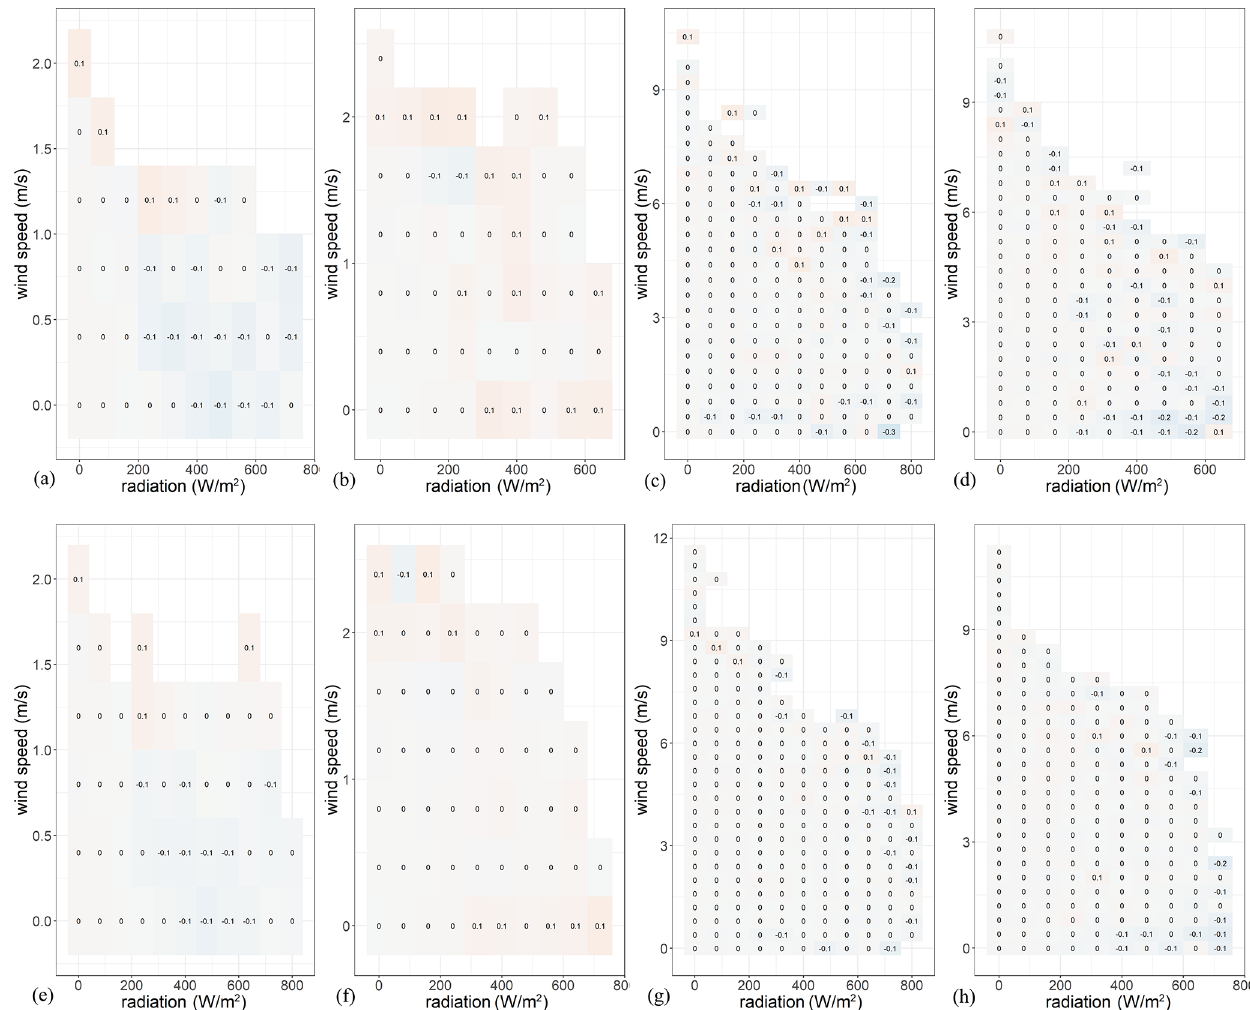
Figure D3. Same as Fig. 11 but for QC level 3. Comparison between (cid:49)T for the test dataset (a–d) and (cid:49)T for the complete dataset (e–h)